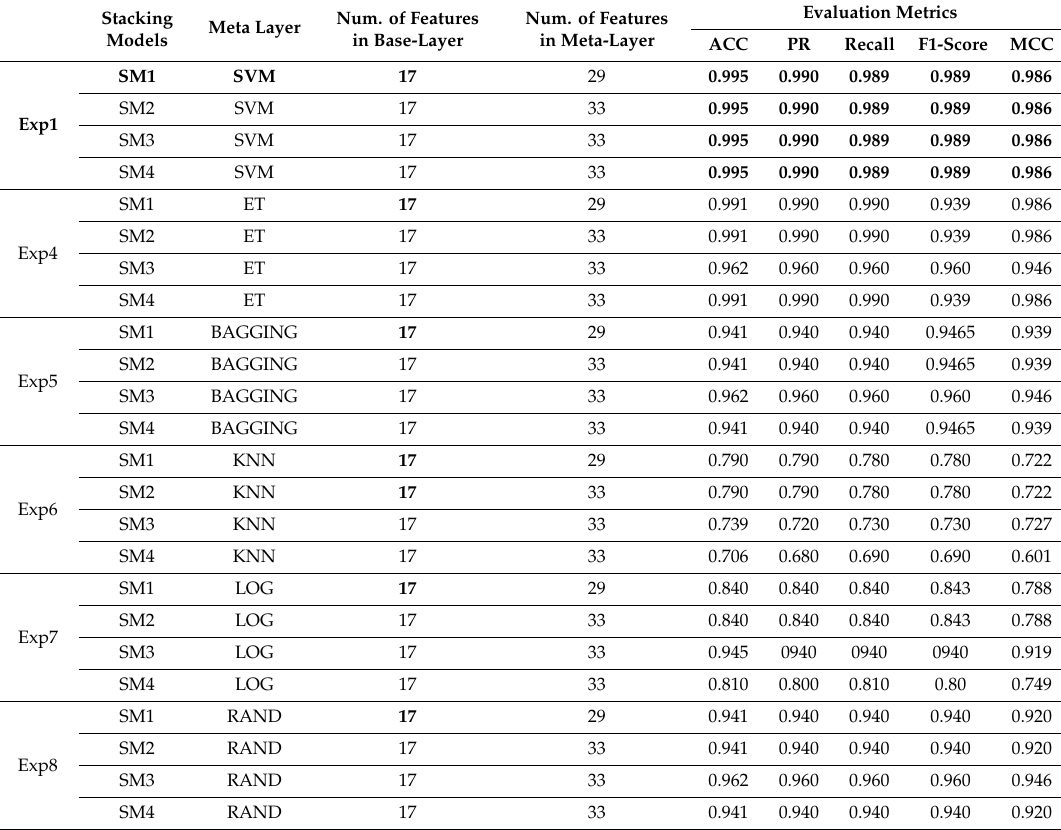
Table A3. Class-wise and average values of performance metrics of stacking models on CT scan dataset for di ff erent experiments, Exp1, Exp4, Exp5, Exp6, Exp7, and Exp8, with di ff erent classifiers in